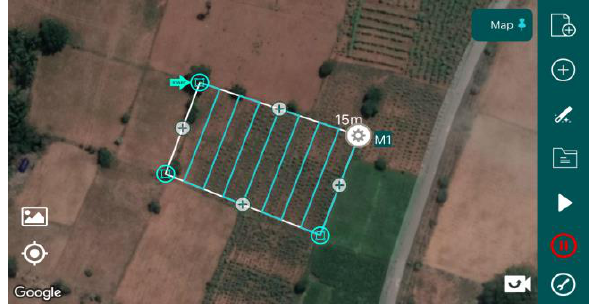
Figure 1 . Flight mission plan for the study area set for altitude 15m in Hammer app (™).